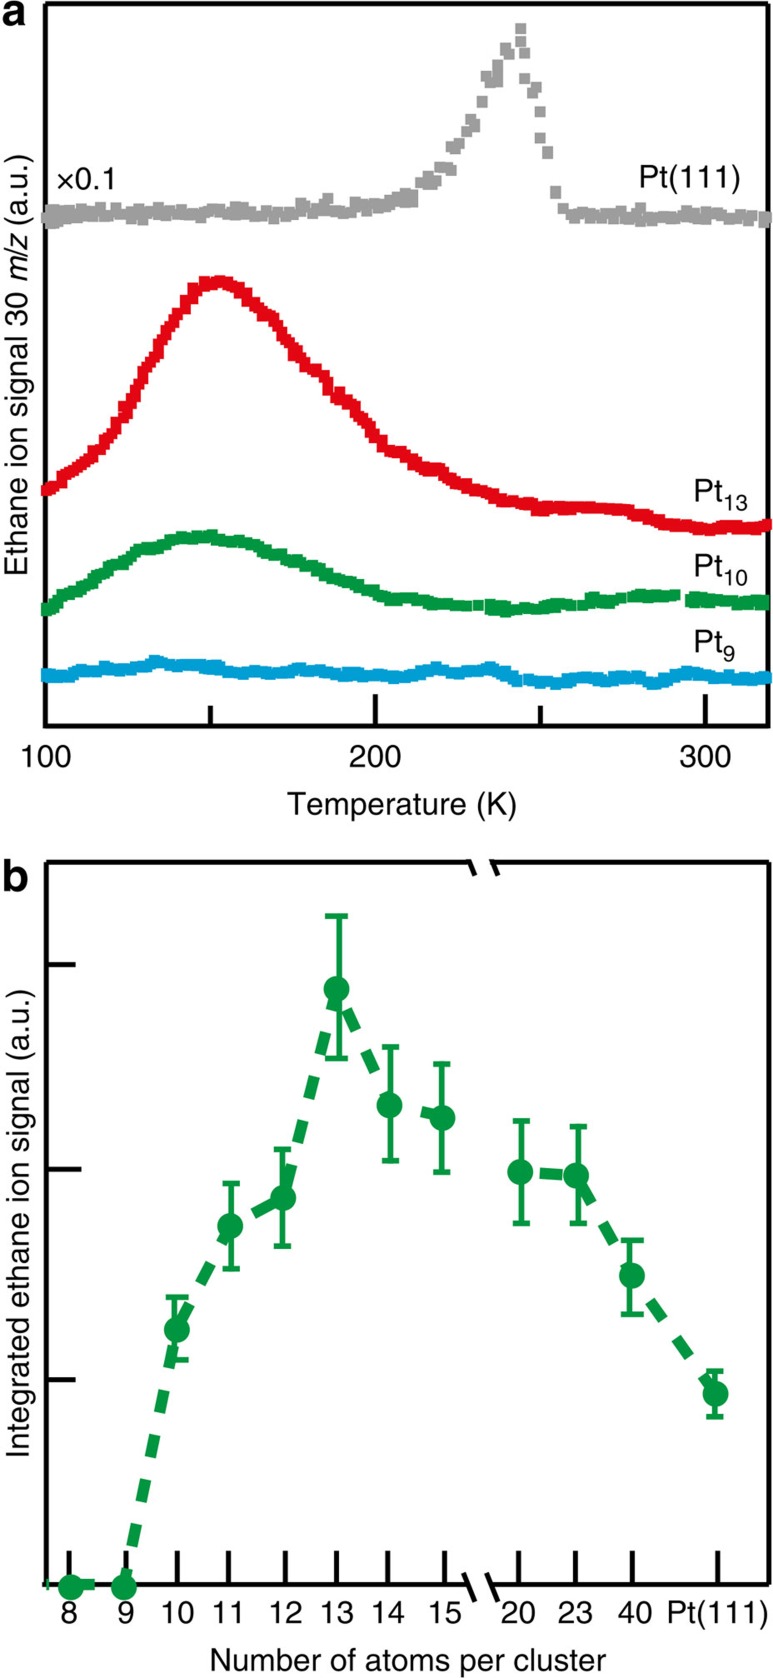
TPR of ethylene hydrogenation on Ptn clusters and Pt(111).(a) The measured ethane ion signals (m/z=30) for Pt9, Pt10, Pt13 and Pt(111) as a function of substrate temperature are shown. (b) The integrated signal from the curves in a as well as for cluster sizes up to Pt40 normalized to the number of Pt atoms, are displayed. The TPR experiments were performed by first dosing 0.4 H2 molecules per MgO surface atom (1 cm2=2.25 × 1015 surface atoms) followed by 0.4 C2H4 ethylene molecules per MgO surface atom at 100 K followed by applying a temperature ramp of 2 K s−1. The error bars represent a 16% error, which was determined from multiple measurements on a single cluster size.